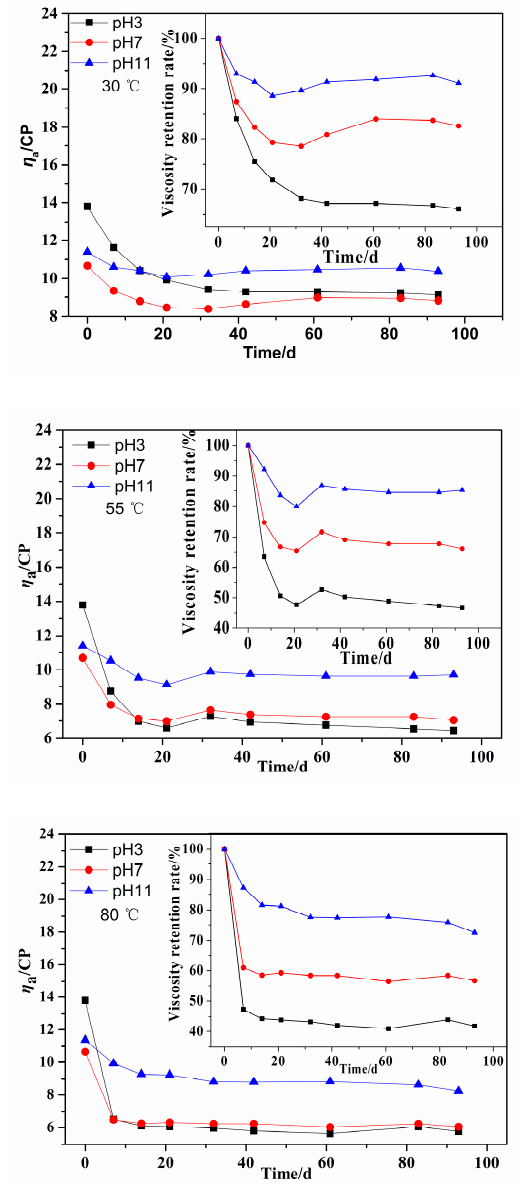
Figure 4. Effect of pH on η a of PMAPTAC solution.